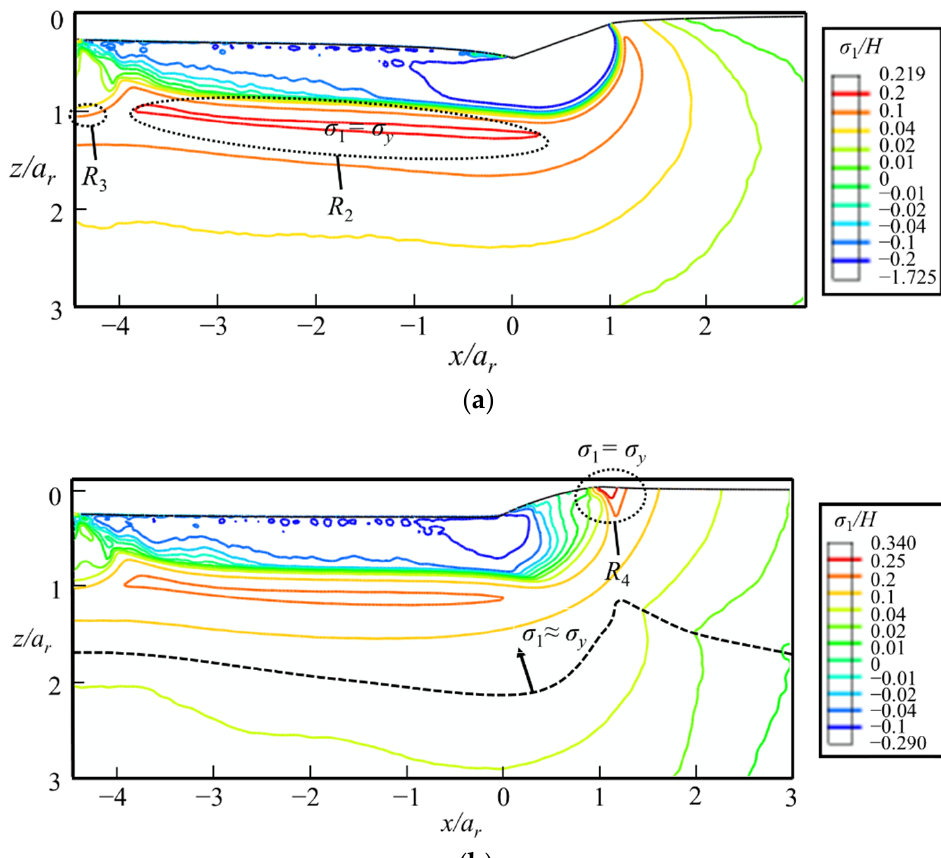
Figure 19. The contours of σ 1 / H at the ( a ) fully loaded and ( b ) fully unloaded states in the xz -cross- section. The thick dash line is the boundary between σ 1 ≈ σ y and σ 1 ≈ σ *, where σ * is the in-plane principal stress.